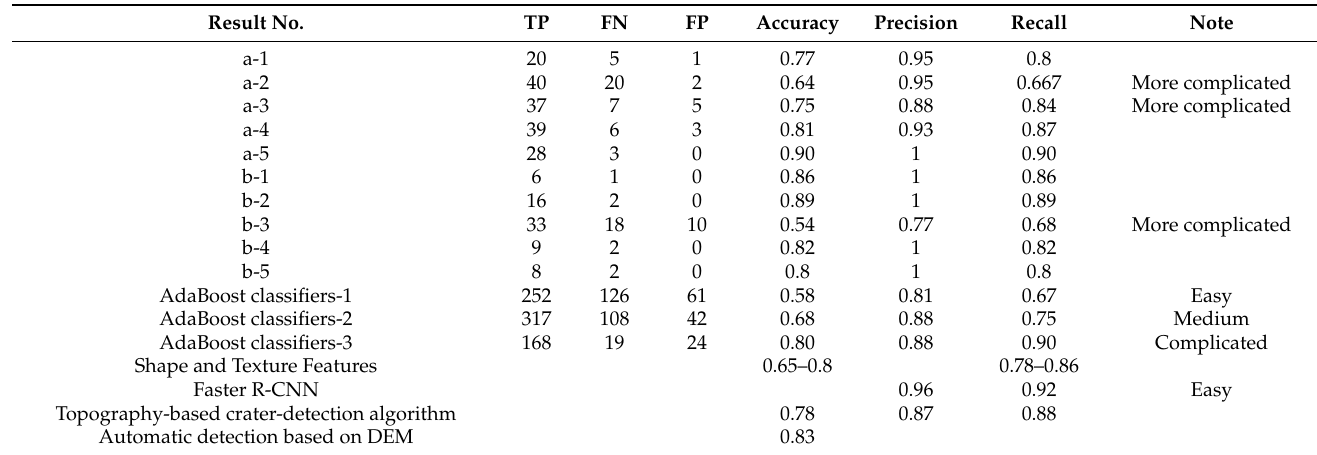
Table 4. The results compared with previous